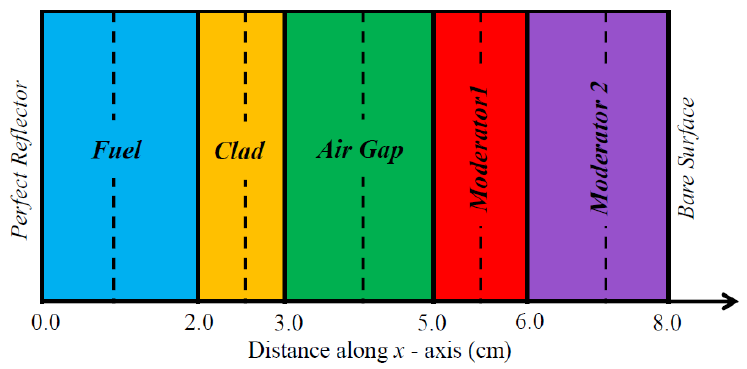
Figure 4. The general scheme of the geometry of Reed’s edge cell problem.